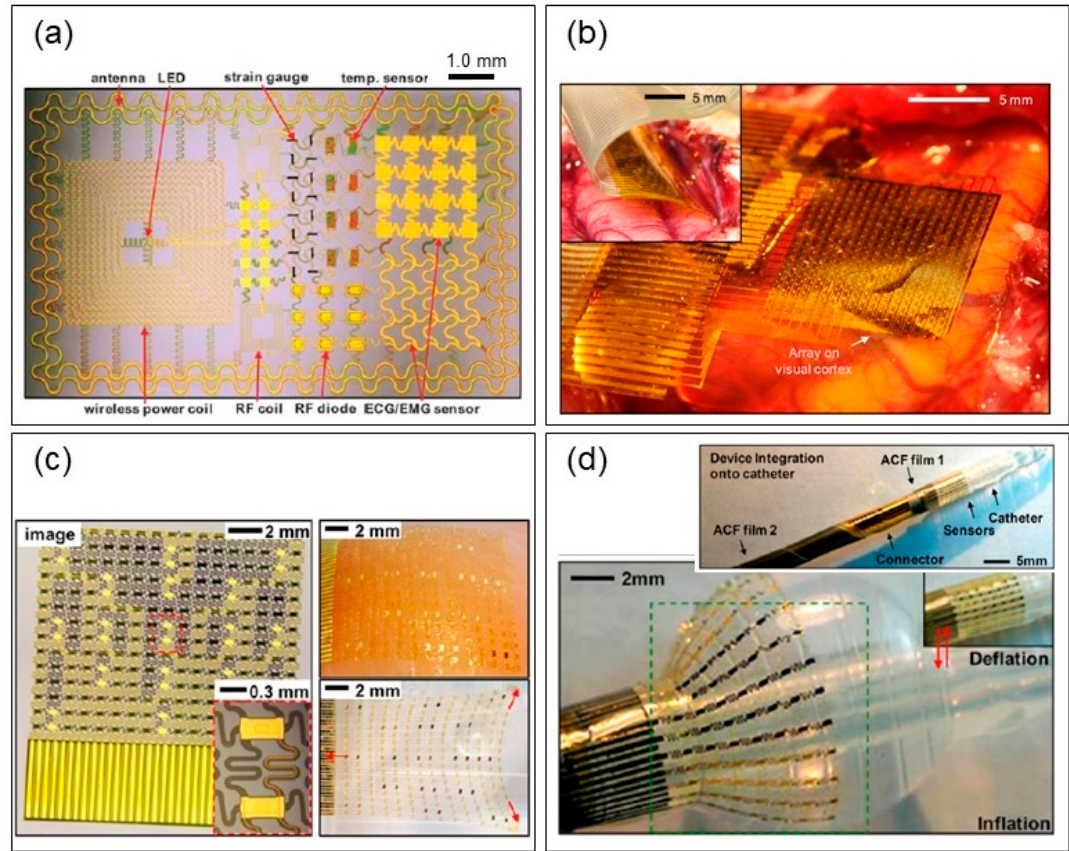
Figure 8. Applications of flexible and stretchable electronics ( a ) Epidermal electronics on PDMS. Image